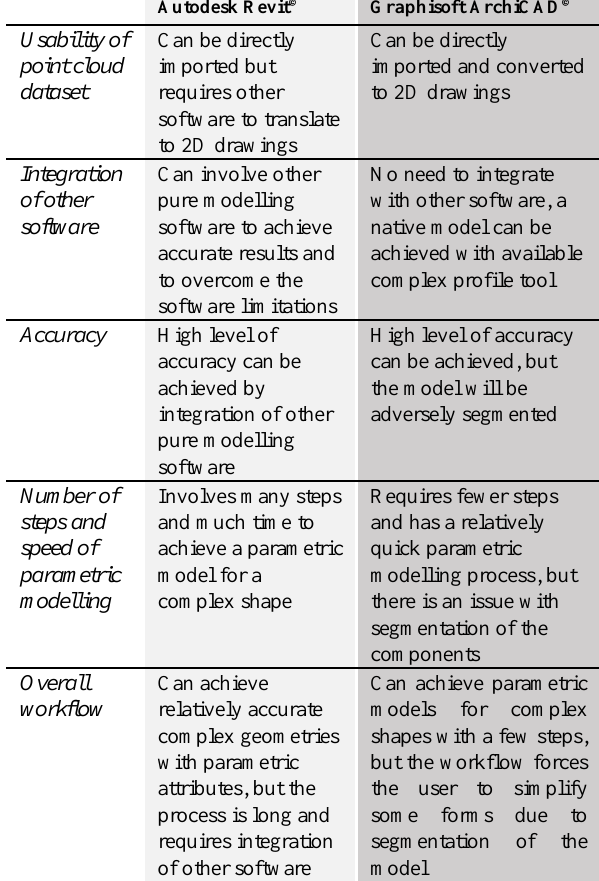
Table. 1. Comparison of BIM workflow for parametric modelling of complex geometris in Revit and ArchiCAD.